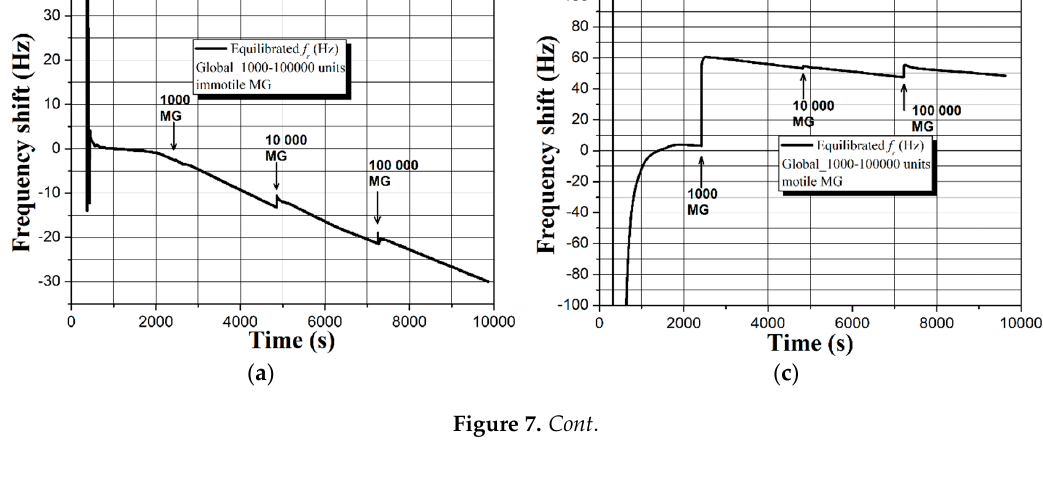
Figure 6. Real-time sensor response of a soot coated 5 MHz QCM to ( a , b ) HSA and immotile and ( c , d ) HSA and progressively motile human spermatozoa with gradually increasing concentration. All graphs reflect actual biomass effects after equilibration of the baselines in Global medium.